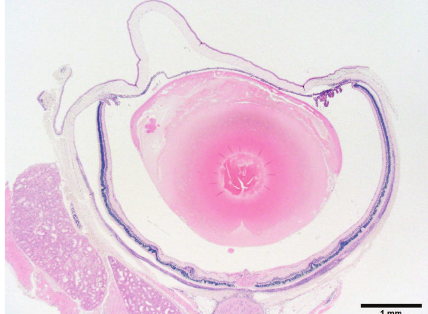
Figure 1: Photomicrograph of the eye of a 50-week-old female SDT fatty rat. Low power magnification of an eye showing deformation of lens, disarrangement of the retina (retinal fold), and infiltration of inflammatory cells in the uveal tract. Bar = 1mm. Hematoxylin and